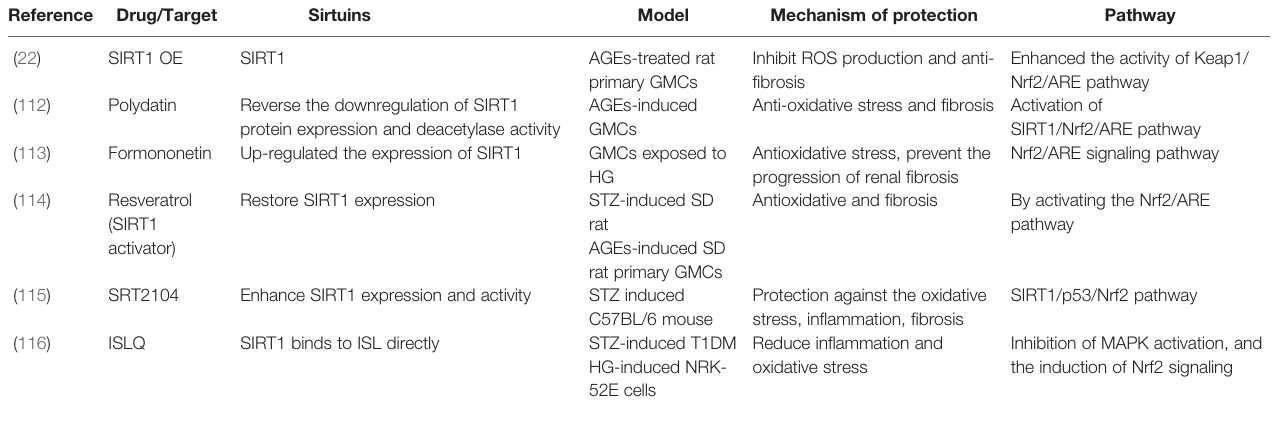
TABLE 7 | DKD studied on Keap1/Nrf2/ARE